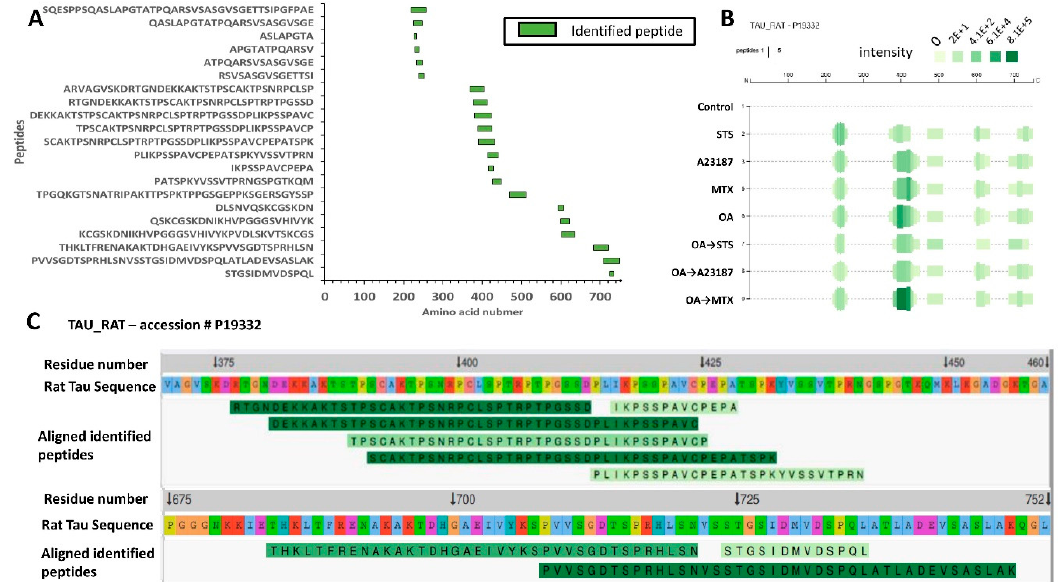
Figure 8. Identification of tau neuropeptides from conditioned media following neurotoxin challenges in rat cerebrocortical neurons. ( A ) Schematic representation for tau peptides generated and released into conditioned media. Peptides detected from control samples are not shown. Green box represents the identified peptide. ( B ) Peptide intensity profile of -rat Tau (accession #: P19332) digested by calpain-1. At each amino acid residue along the protein, the height of the green bars is proportional to the count of peptides overlapping this position. The intensity of the color (green) is proportional to the sum of the peptide intensities overlapping this position. ( C ) A customized Peptigram peptide alignment map compiled from rat tau-752. Peptides from the input data are highlighted in green. The intensity of each peak detected by mass spectrometry is represented by a green color gradient, the darker the green color the higher the intensity. This alignment is generated from tau-752 starting from the N-terminal domain: a.a. 375–752.